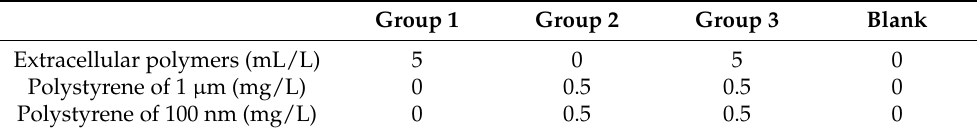
Table 1. The composition of feed solutions in three groups in the FO system. Group 1 Group 2 Group 3 Blank Extracellular polymers (mL/L) 5 0 5 0 Polystyrene of 1 µ m (mg/L) 0 0.5 0.5